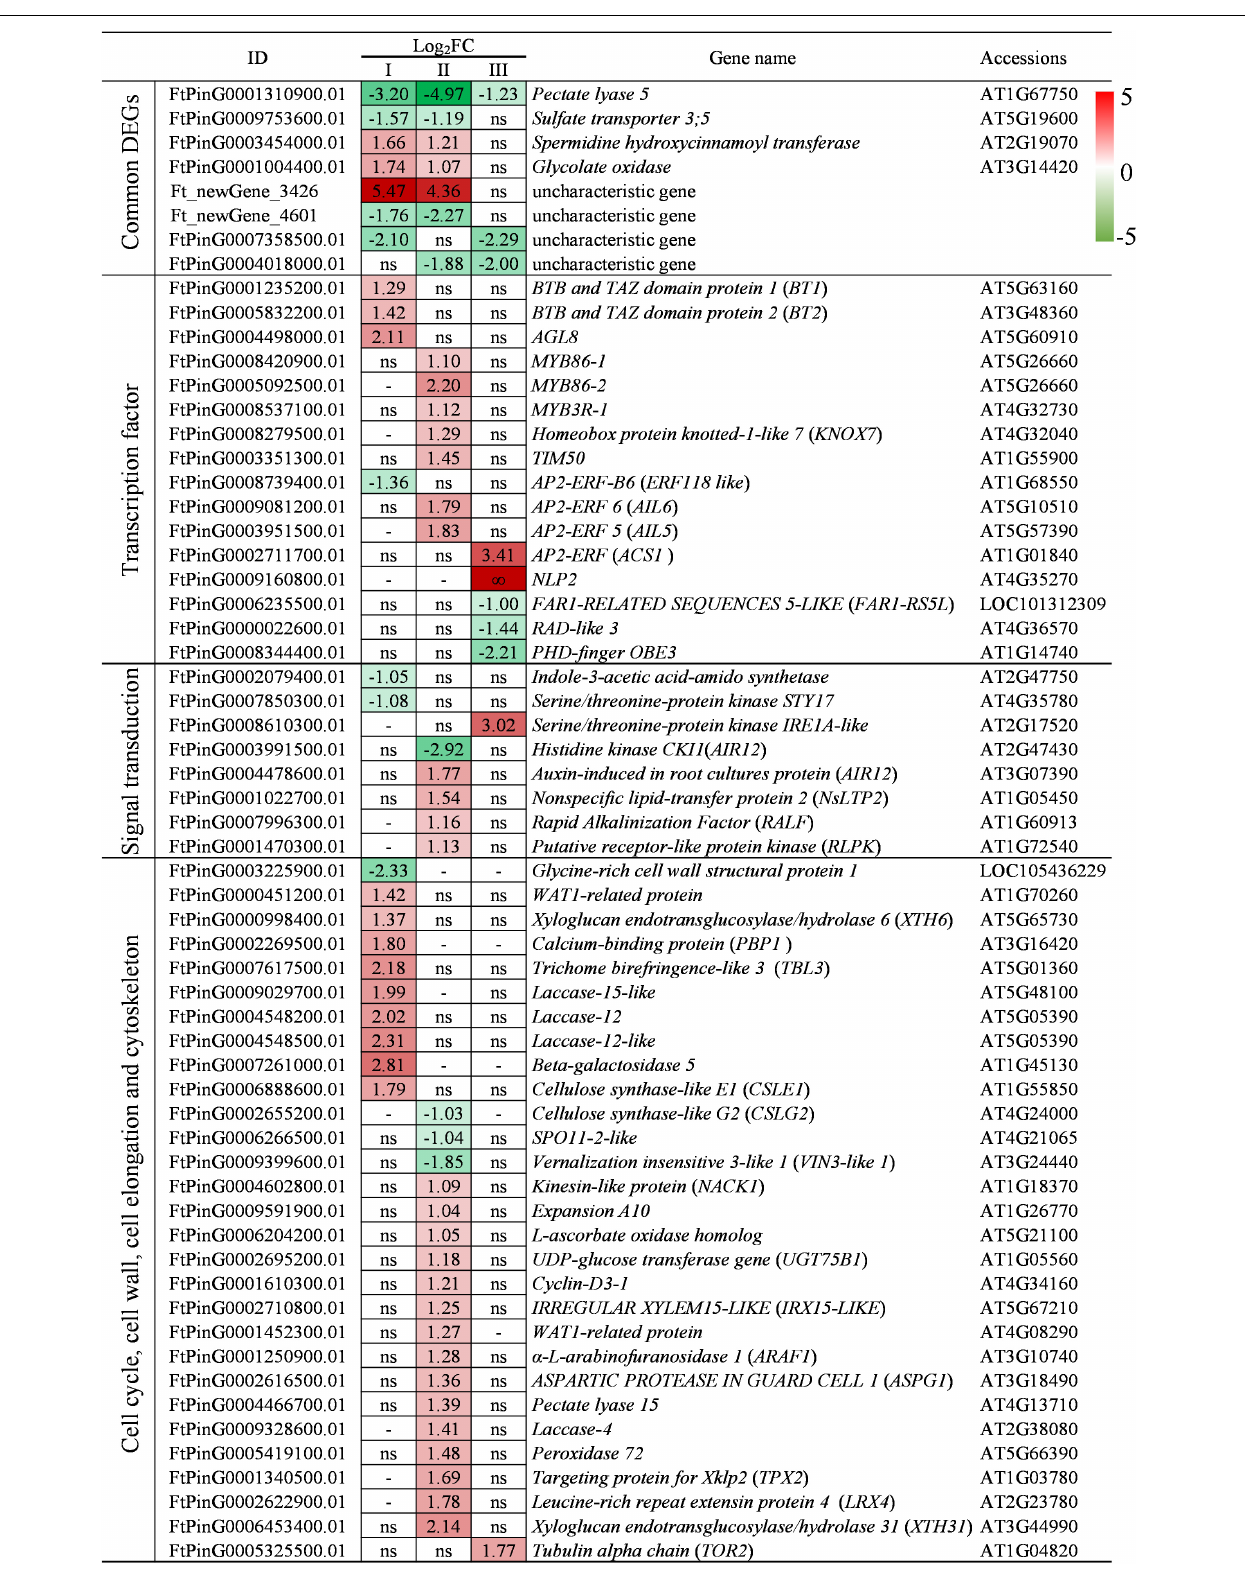
Frontiers in Plant Science |